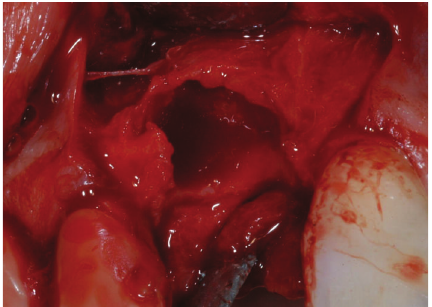
Figure 4: Immediately after tooth extraction, the alveolar bone review depicted a huge bone defect ( > 8mm) with loss of a consid- erable amount of buccal bone.